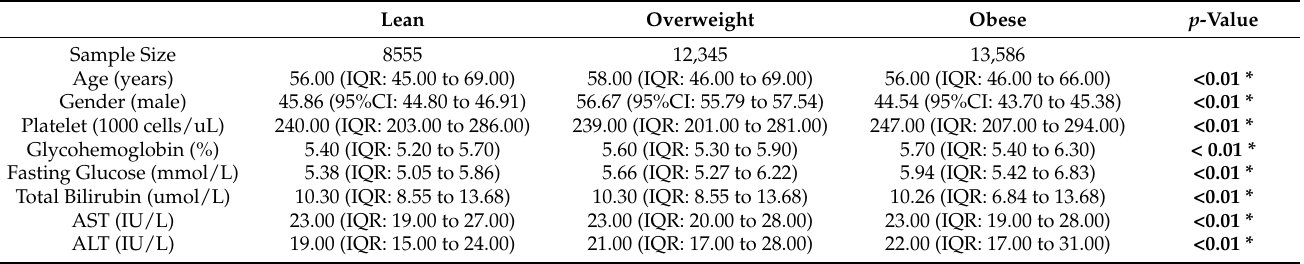
Table 1. Clinical Characteristics of Lean, Overweight, and Obese Population at Time of Survey. Lean Overweight Obese p -Value Sample